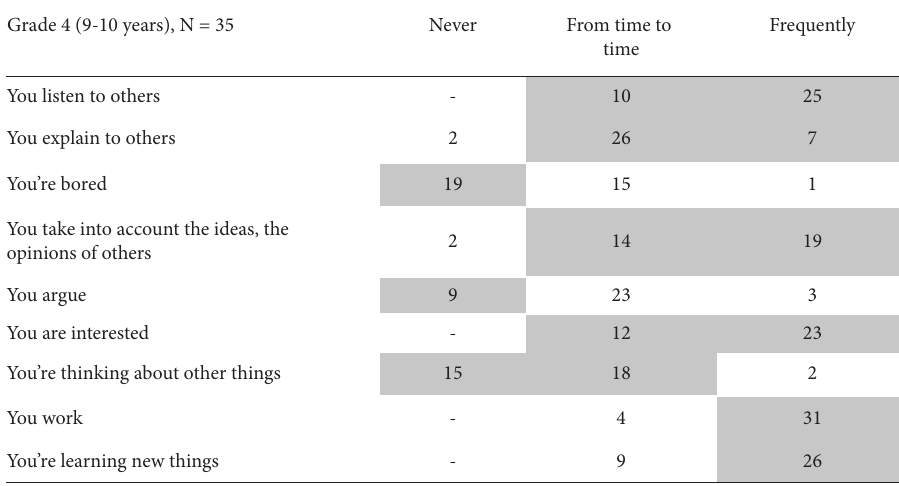
Figure 8: Breakdown of opinions among pupils in grade 4 based on how they work in a group (significance level of p � 0 .